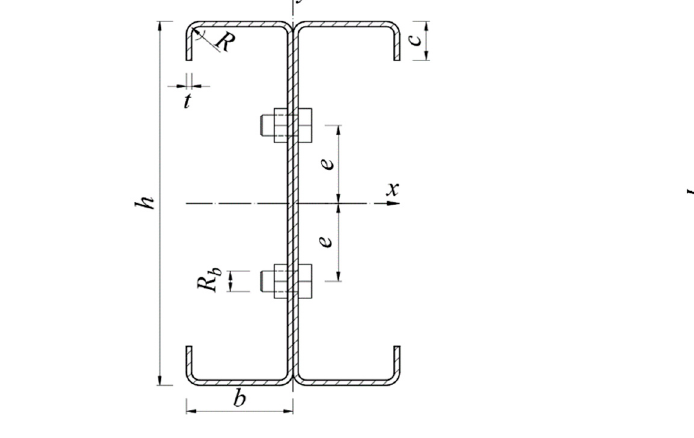
Figure 2. Parameters in the combined column.